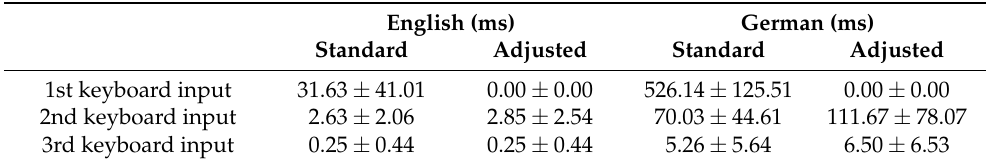
Table 1. Mean and standard deviation of computing times in milliseconds, employed to compile the list of word suggestions that favor frequently used words for the first, second, and third keyboard inputs, using the German and English dictionaries in the standard and adjusted